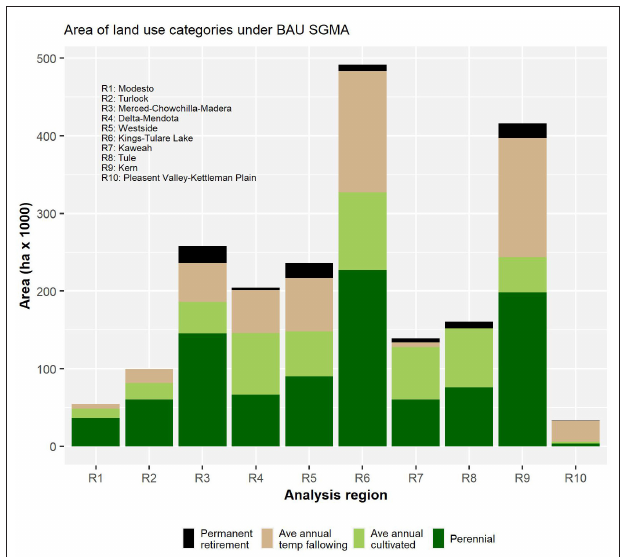
FIGURE 3 | Projected distribution of land uses on present day agricultural footprint for each region in our study area under a BAU SGMA future. Black corresponds to permanent retirement relative to a no-SGMA future, while the combination of average temporary fallowing and average cultivation of annuals represents a footprint of land under annuals under BAU SGMA. Annual croplands are generally lower return and more flexibly re-allocated than land under perennial crops (dark green).